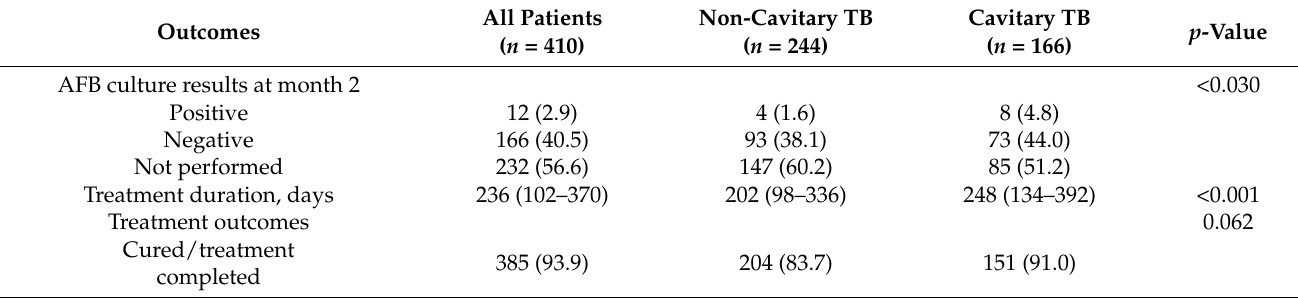
Table 4. Treatment outcomes for all patients with cavitary and non-cavitary